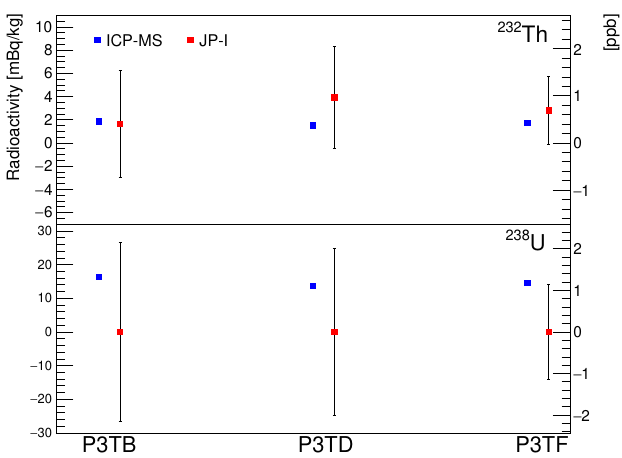
Figure 5. Cross validation for ICP-MS and JP-I HPGe for SS samples with batch number P3TB, P3TD, and